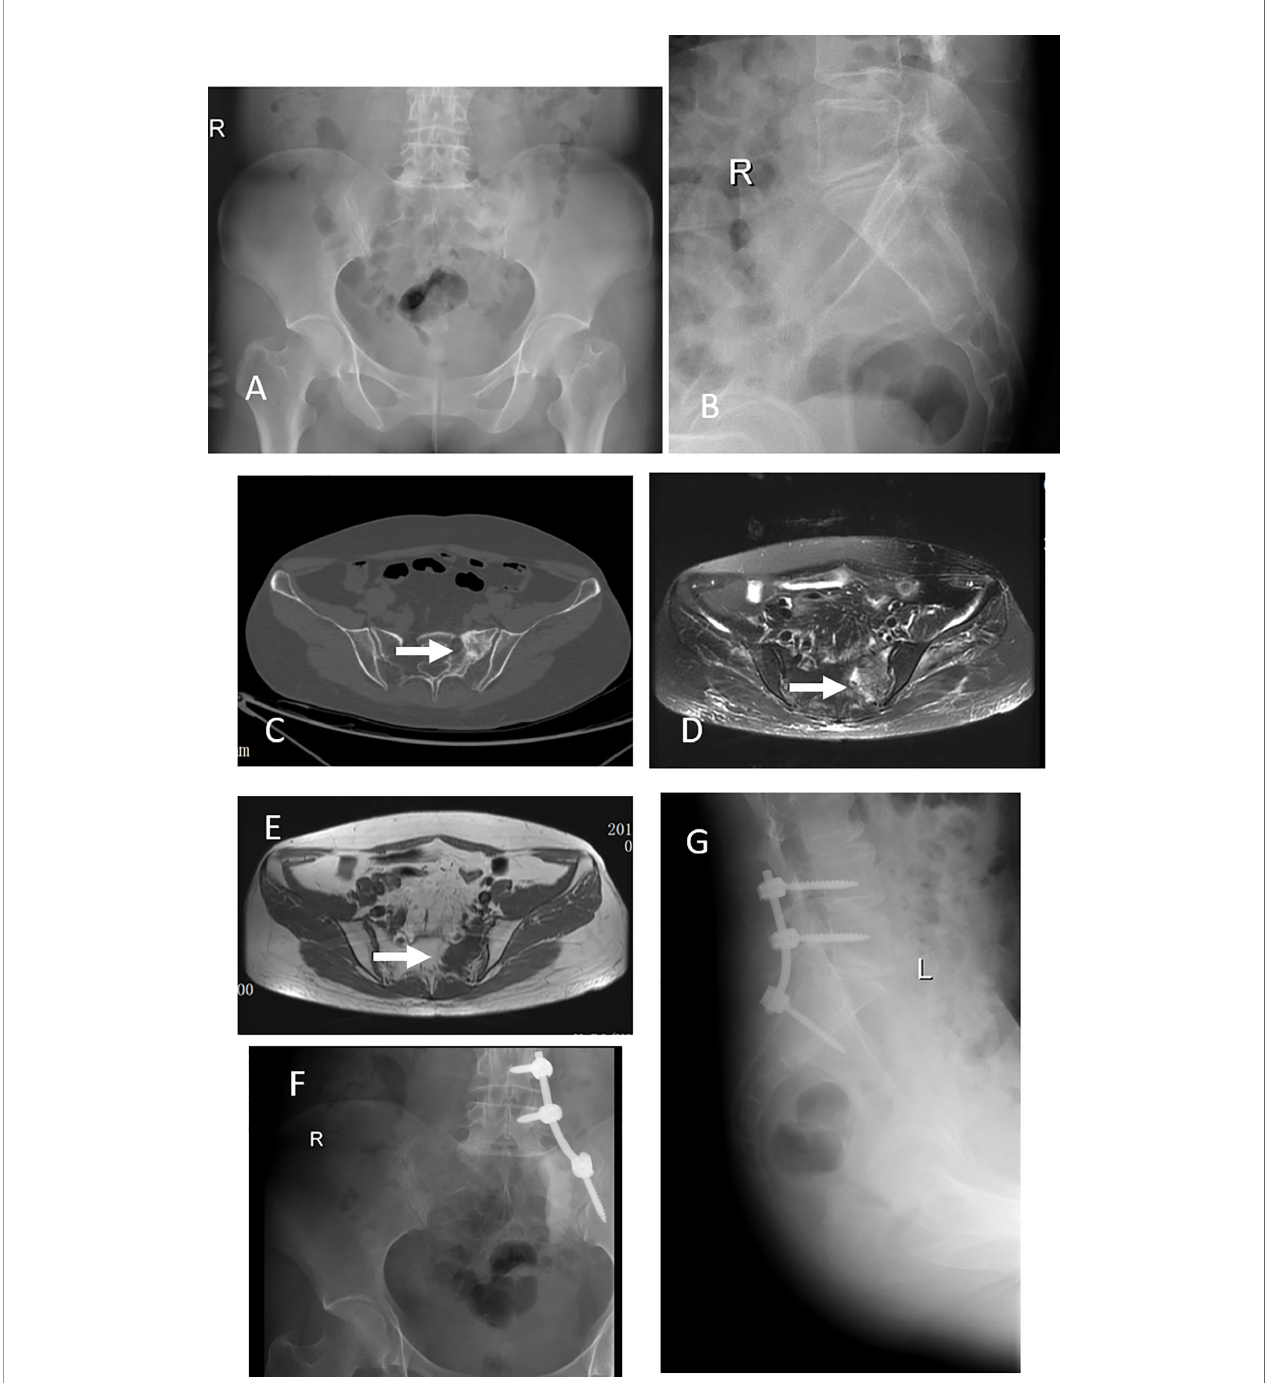
FIGURE 1 | This 42 years old woman had severe back pain after breast cancer treatment for 7 years. X-ray and CT scan showed a tumor at left S1-2 (A – C) , an arrow indicate the lesion. MRI scan, both T1 and T2, indicated the tumor occurred in the left S1-2 (D, E) . This patient got a subtotal resection and pedicle screw fi xation (F, G)